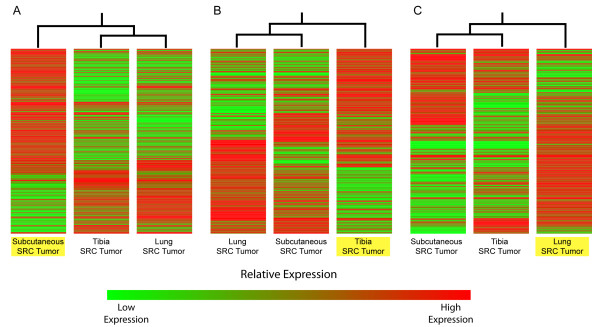
Tumor transplantation site significantly alters the gene expression profiles of the SRC tumors. Since the SRC tumors at different transplant sites originated from the same source tumor, the unique SRC gene expression profiles at each transplant site are likely a result of interactions in the microenvironment between tumor cells and host cells. For each gene expression comparison (A-C), a different tumor was selected as a "reference sample"(highlighted in yellow). The gene expression of the "reference sample" was then compared with the gene expression profiles of the other tumors. For each comparison, the upregulation/downregulation refers to the status of the genes in the "reference sample" compared to the tumor samples. (A) Differential gene expression between the Subcutaneous SRC tumor (reference sample; highlighted in yellow) and SRC tumors at the other transplantation sites (200 genes upregulated; 107 genes downregulated in the Subcutaneous SRC tumor). (B) Differential gene expression between the Tibia SRC tumor (reference sample; highlighted in yellow) and the SRC tumors at the other transplantation sites (106 genes upregulated; 108 genes downregulated in the tibia SRC tumor). (C) Differential gene expression between the Lung SRC tumor (reference sample; highlighted in yellow) and the SRC tumors at the other transplantation sites (157 genes upregulated; 73 genes downregulated in the lung SRC tumor). Color bar illustrates relative gene expression levels. See "Methods" for additional description (Gene expression comparisons between SRC tumors), and see Additional file 3 for complete data set and annotation of the genes presented within this figure.